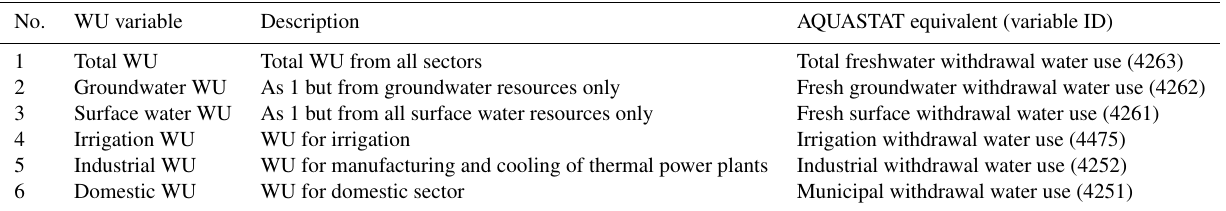
Table 3. AQUASTAT variables used for evaluating WaterGAP 2.2d potential withdrawal water use WU, including variable ID reference of